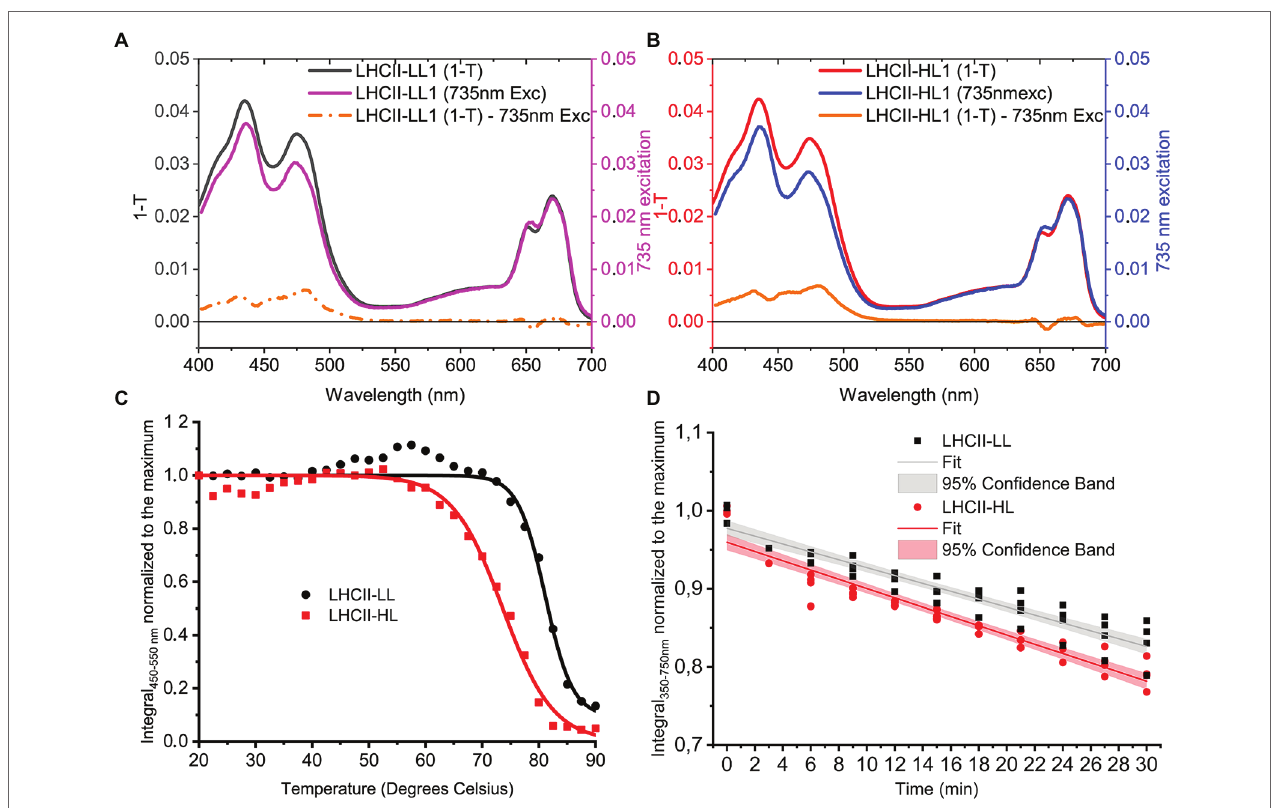
FIGURE 5 | Properties of LHCII-LL and LHCII-HL. ( A ; LHCII-LL) and ( B ; LHCII-HL) Carotenoid to Chl EET efficiency, tested by comparing the fitted 1-Transmission (1-T) and fluorescence excitation spectra normalized to the Chl a content (Full details in Supplementary Figures S3, S4 ) (C) . Thermostability of LHCII-LL and LHCII-HL measured by the loss of the CD signal between 450 and 550 nm (the absolute area was used). The lines represent a sigmoidal fit of the data (D) . Photo- stability of LHCII-LL and LHCII-HL tested by the photobleaching with a 4,500 μ mol photons m − 2 s − 1 halogen lamp. Data from two biological and two technical replicates normalized to the average integral of the initial (maximum) absorption and fitted with a linear